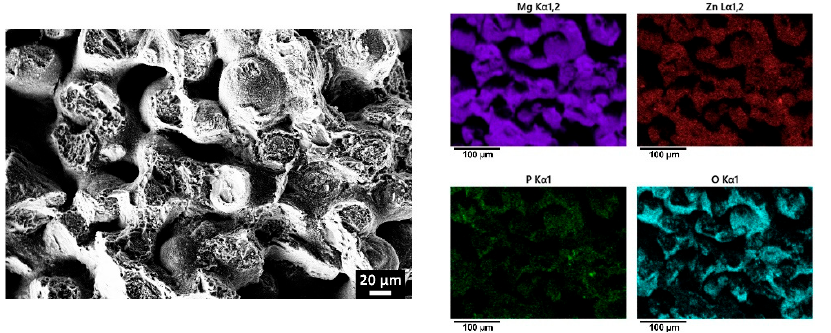
Figure 8. SEM and EDX images of the porous Mg-Zn-Zr scaffold’s fracture surface coated with phosphate conversion coating.